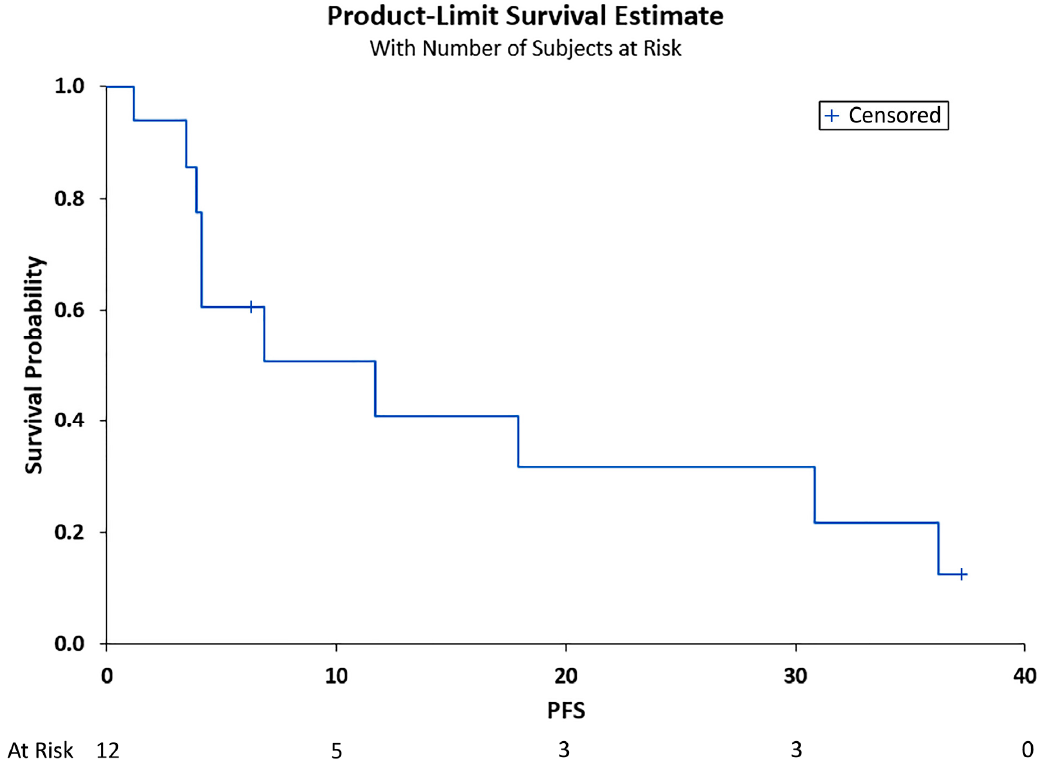
Figure 1. Progression-free survival (PFS) in months. Shown is the PFS after treatment for the total cohort of 12 patients vs. the overall survival probability. Median PFS was 6.89 months (95% CI (3.48, 30.85)).